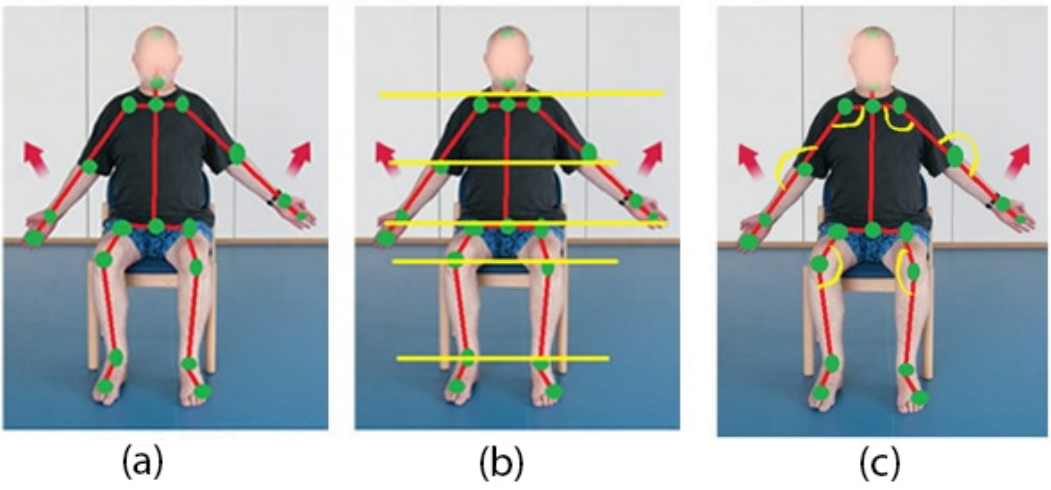
Figure 6. Exercise pose matching: ( a ) tracked skeleton; ( b ) comparing joint positions; and ( c ) comparing joint